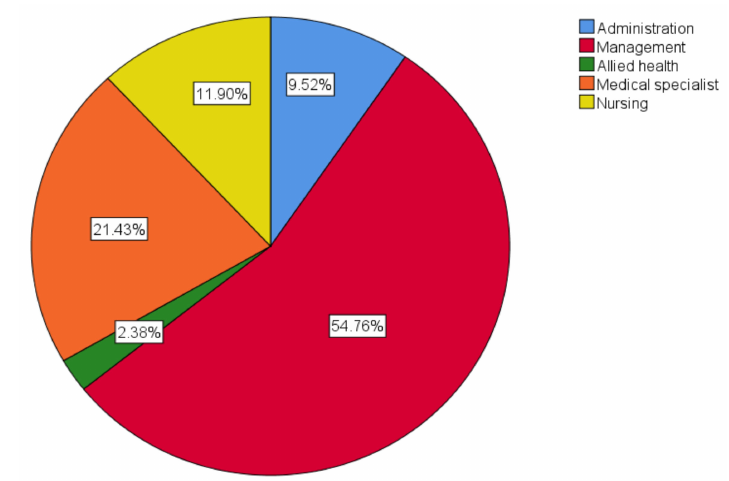
Figure 3. The primary role of the survey responder at the health service.